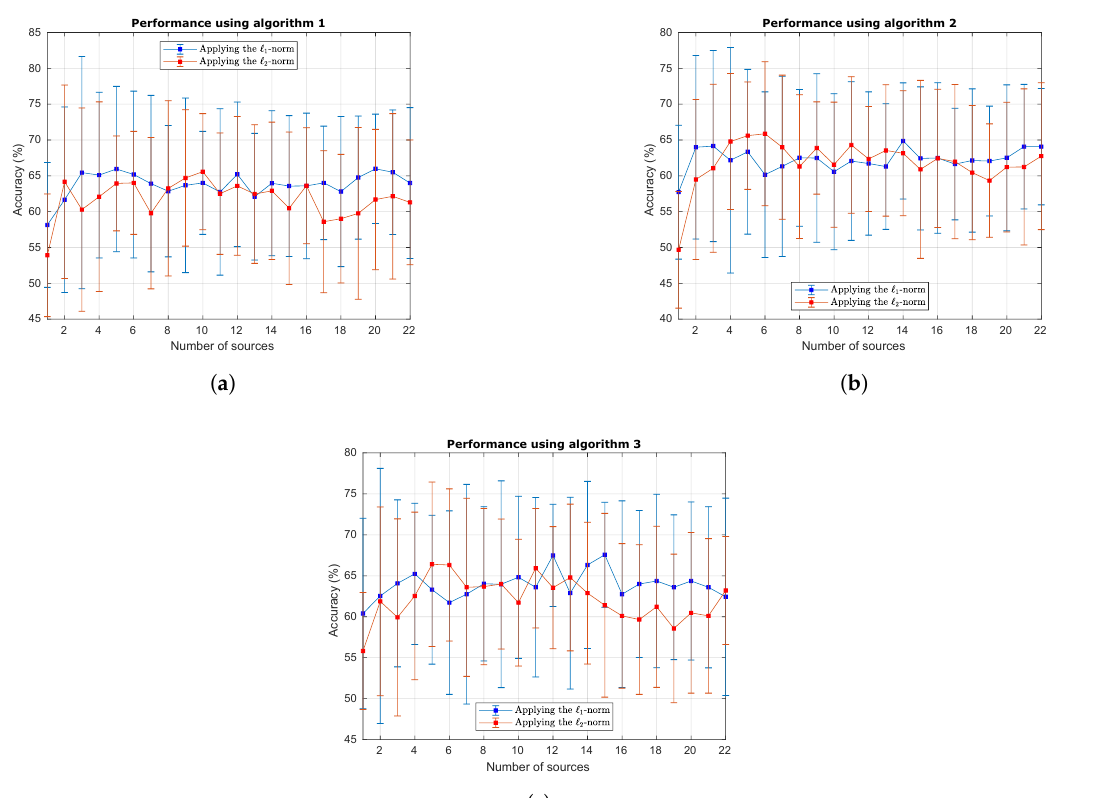
Figure 4. Performance curves obtained with the BCI test dataset when the number of electrodes was reduced. ( a ) Performance curves of Algorithm 1; ( b ) Performance curves of Algorithm 2; ( c ) Performance curves of Algorithm